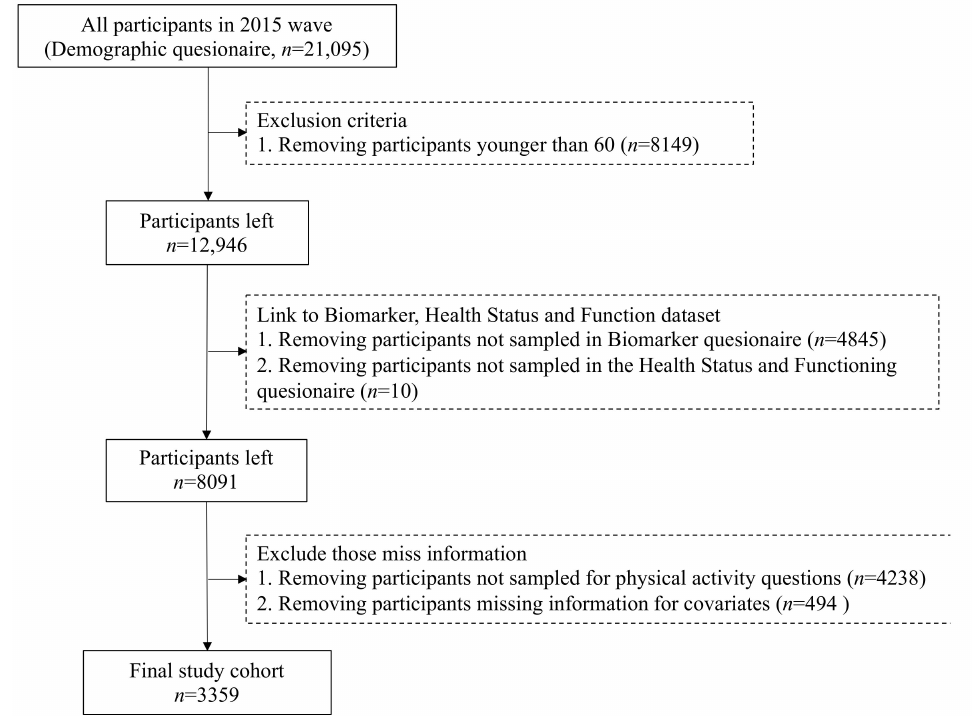
Figure 1. Data extraction and management